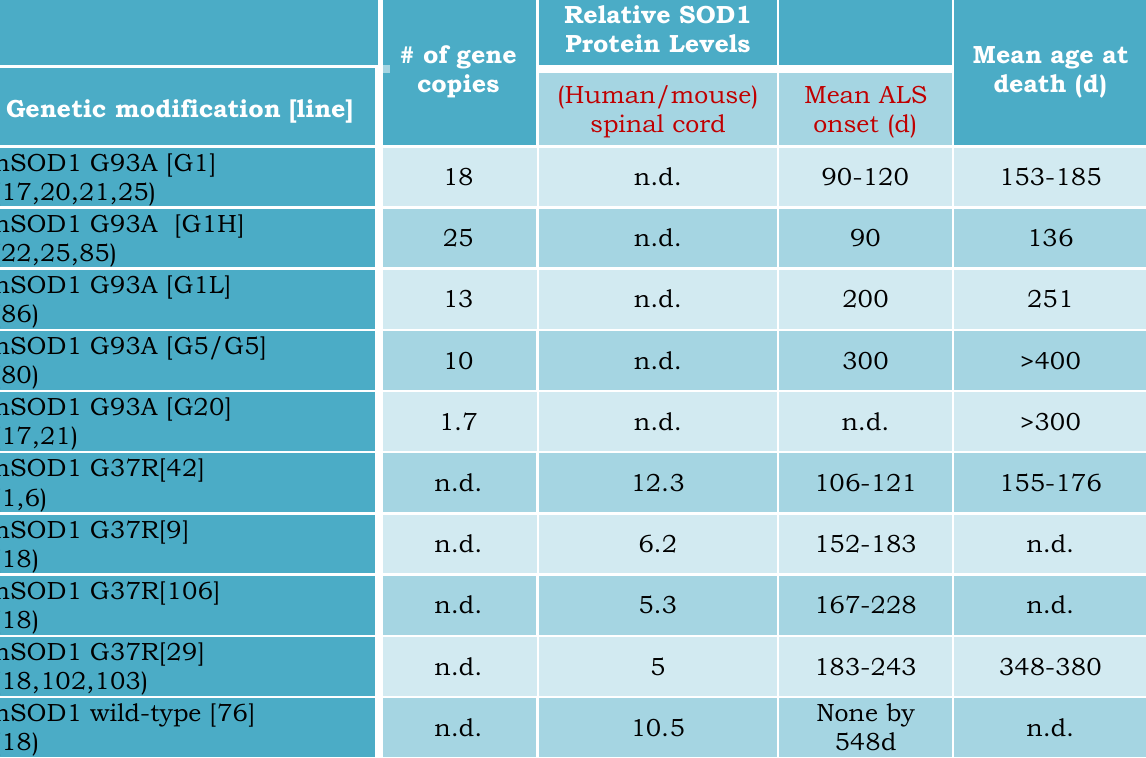
Table 1. Timing of the progressively degenerative phenotype in mSOD1 murine models is highly dependent on the degree of mutant protein